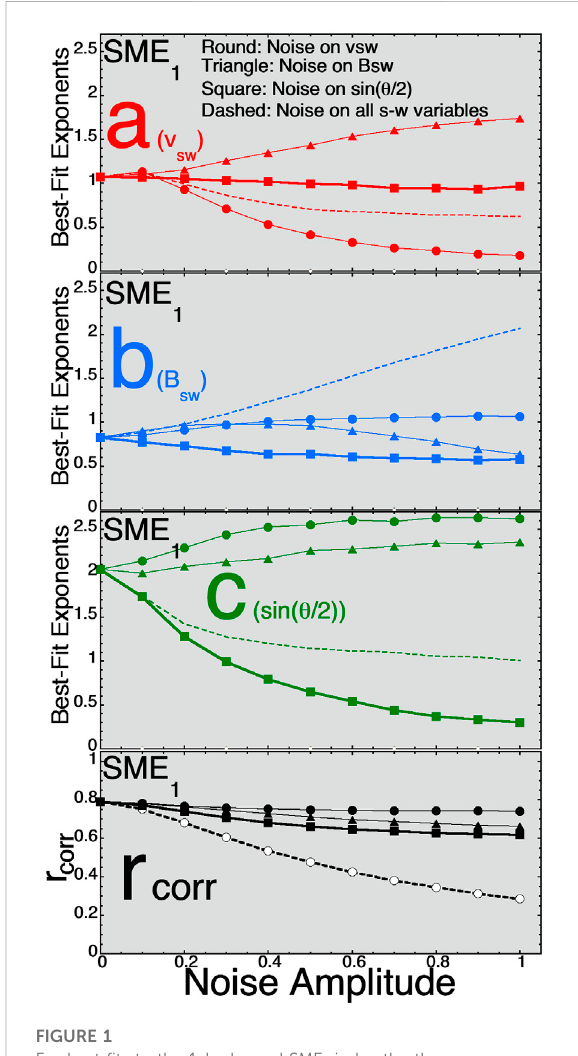
FIGURE 1 For best fi ts to the 1-hr-lagged SME 1 index the three exponents (A) (red, top panel), (B) (blue, second panel), and (C) (green, thirdpanel)are plottedas functions oftheamplitude ofthe Gaussiannoiseaddedtothethreesolar-windvariables.Inthe bottom panel the Pearson linear correlation coef fi cient between D = v sw a B sw b sin c ( θ clock /2) and SME 1 is plotted as a function of the amplitude of the added noise.